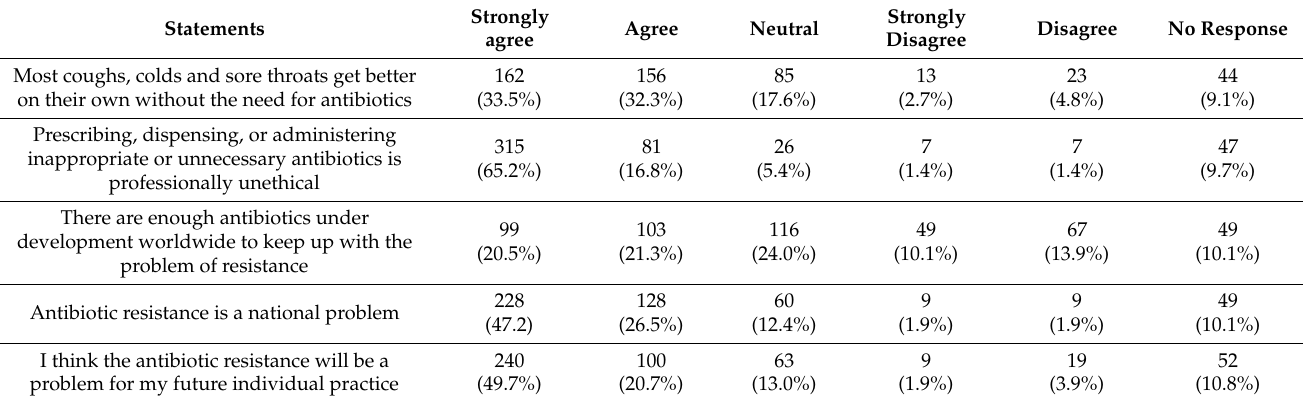
Table 5. Level of agreement or disagreement with antibiotic prescribing